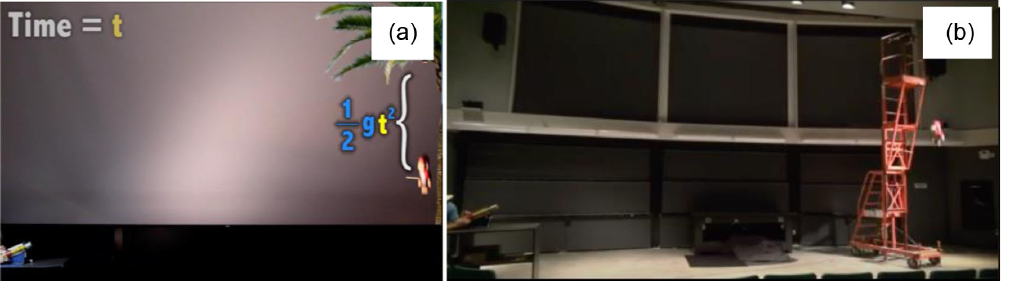
FIG. 4. Screenshot from the shoot the monkey demo video versions which (a) had enhanced visuals (versions 1 and 3) and (b) did not have enhanced visuals (versions 2 and 4).